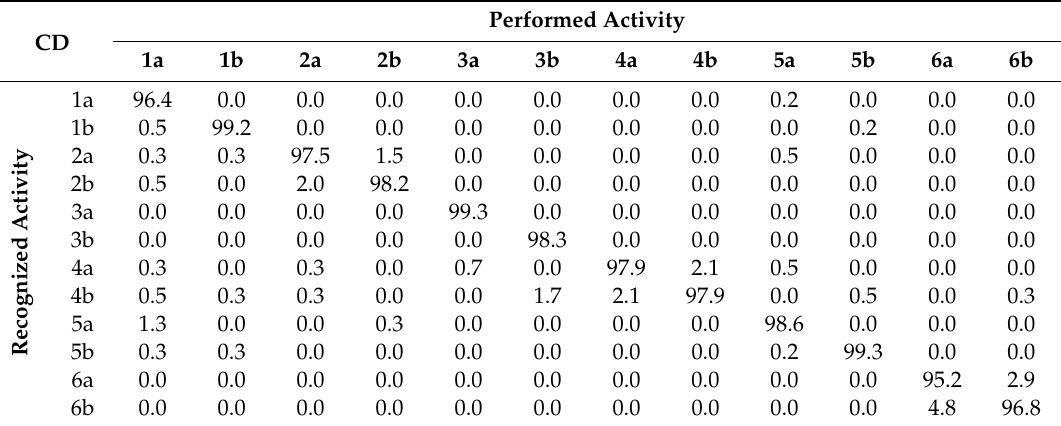
Table A4. Matrix of recognition errors (in %) of 12 motor activities 1a ÷ 6b in test set for all volunteers together for sensor CD.